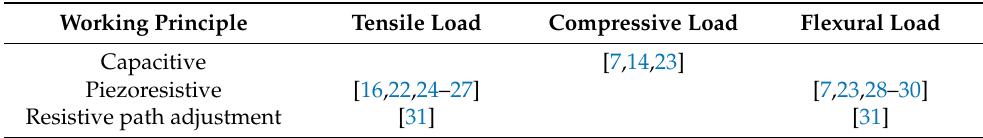
Table 1. Overview of working principles and tested loads in existing literature on additive manufac- turing (AM) of